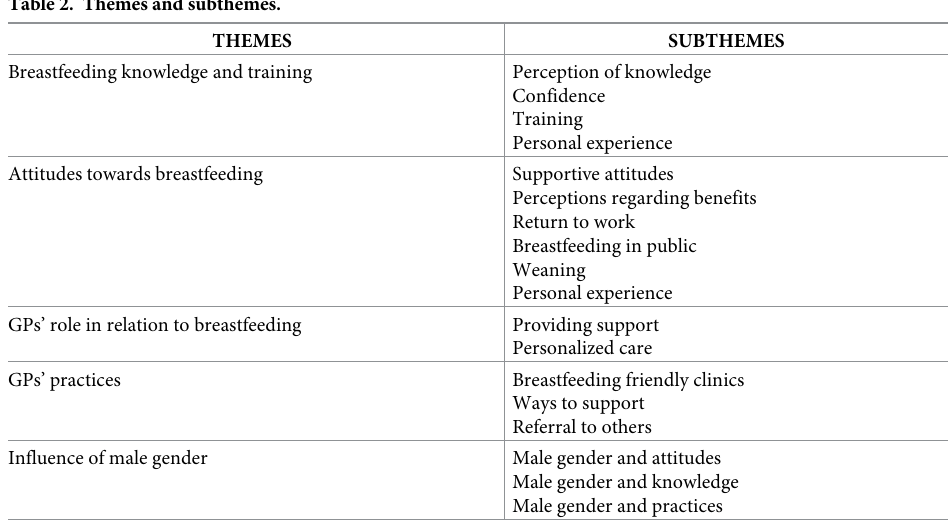
Table 2. Themes and